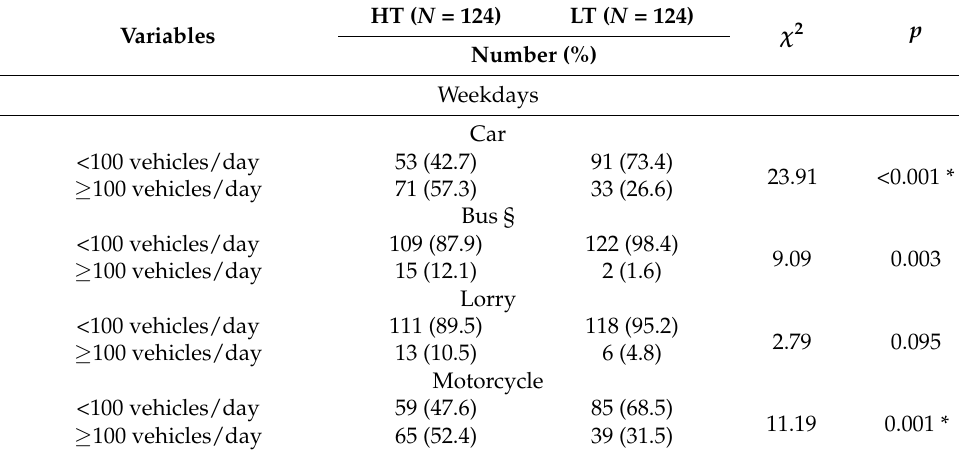
Table 2. Number of vehicles reported by respondents around their residences on weekdays and